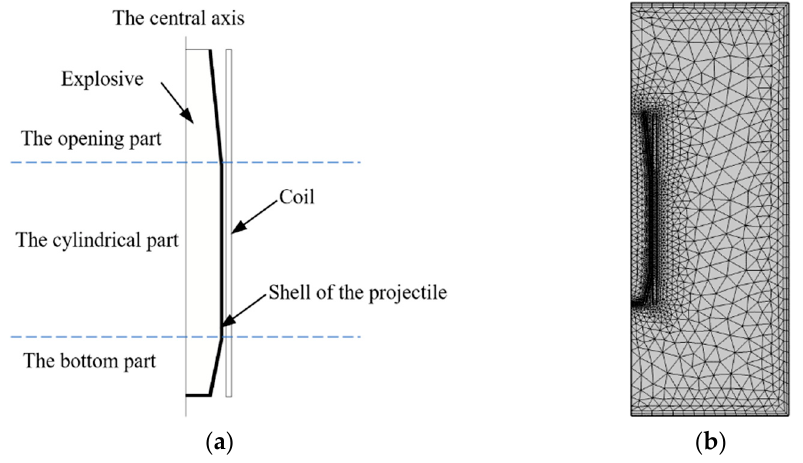
Figure 2. Model for numerical simulation. ( a ) Schematic diagram of the structure. ( b ) Mesh model.